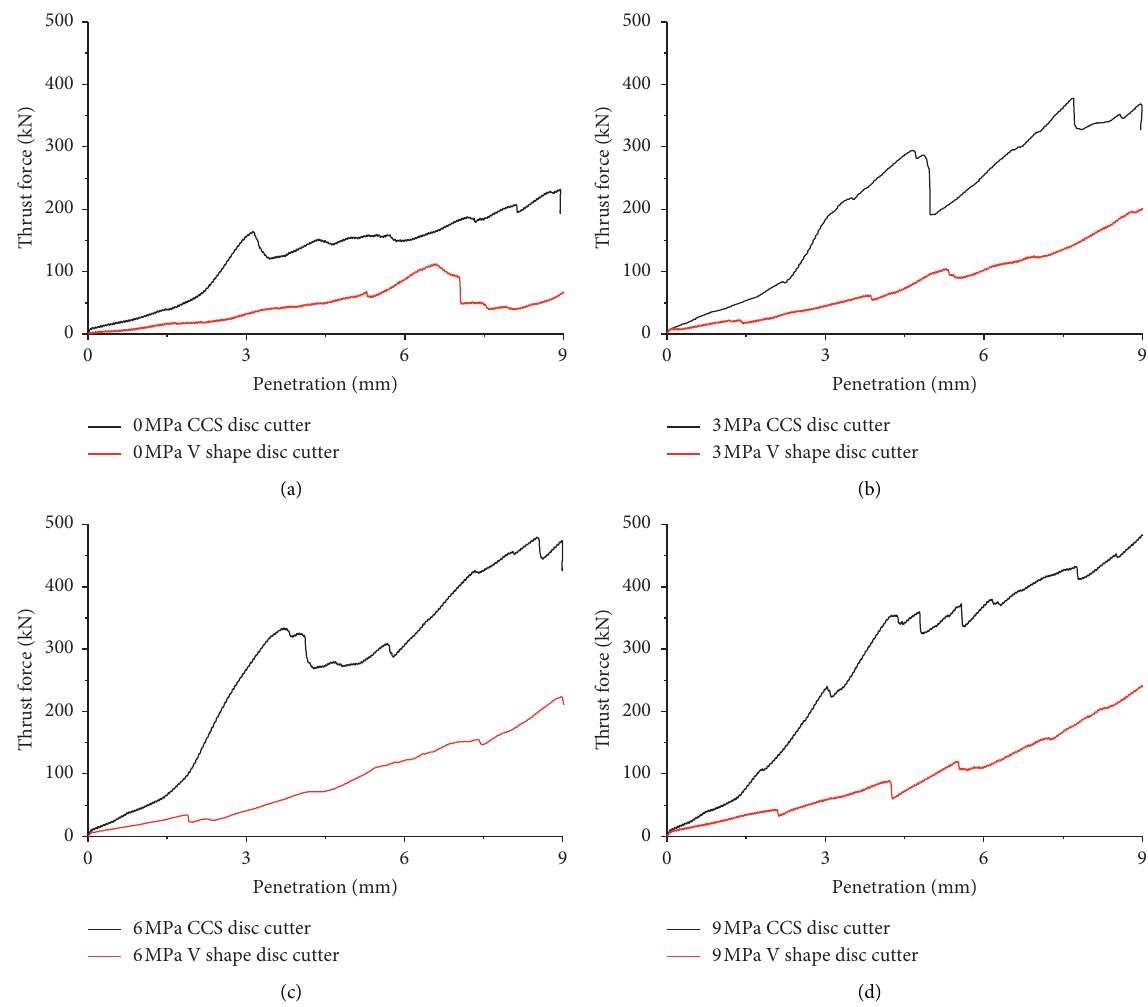
Figure 12: Comparison of thrust forces between CCS and V shape disc cutters. Confining stress: (a) 0 MPa; (b) 3MPa; (c) 6MPa; (d)